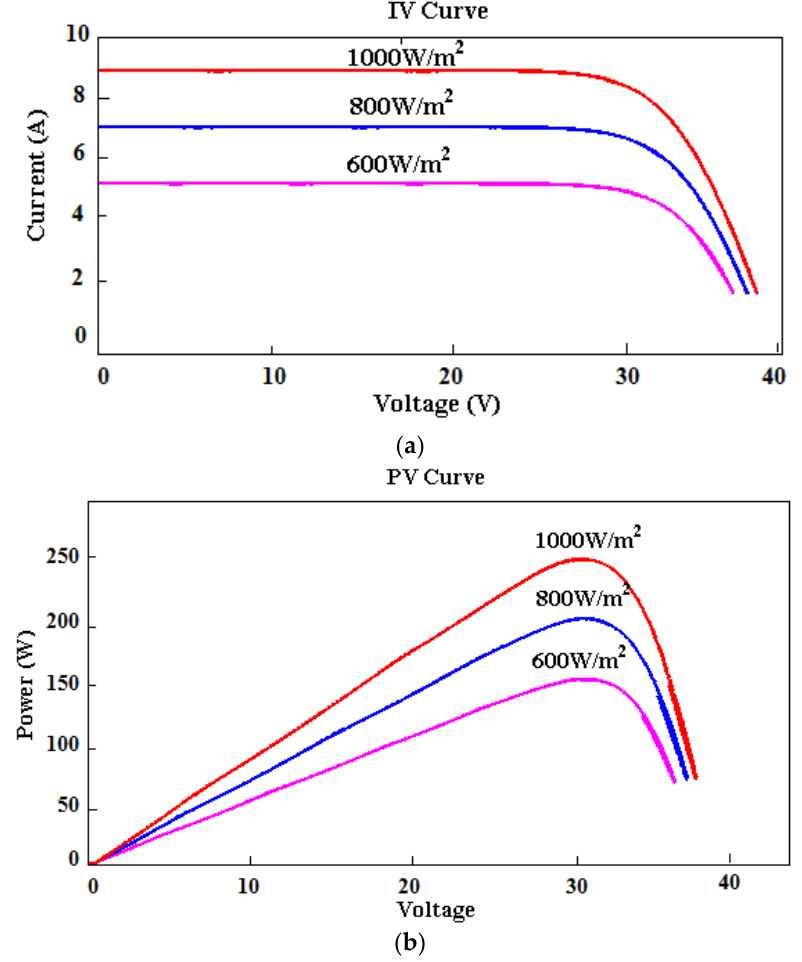
Figure 10. ( a ). IV characteristics. ( b ). PV characteristics.